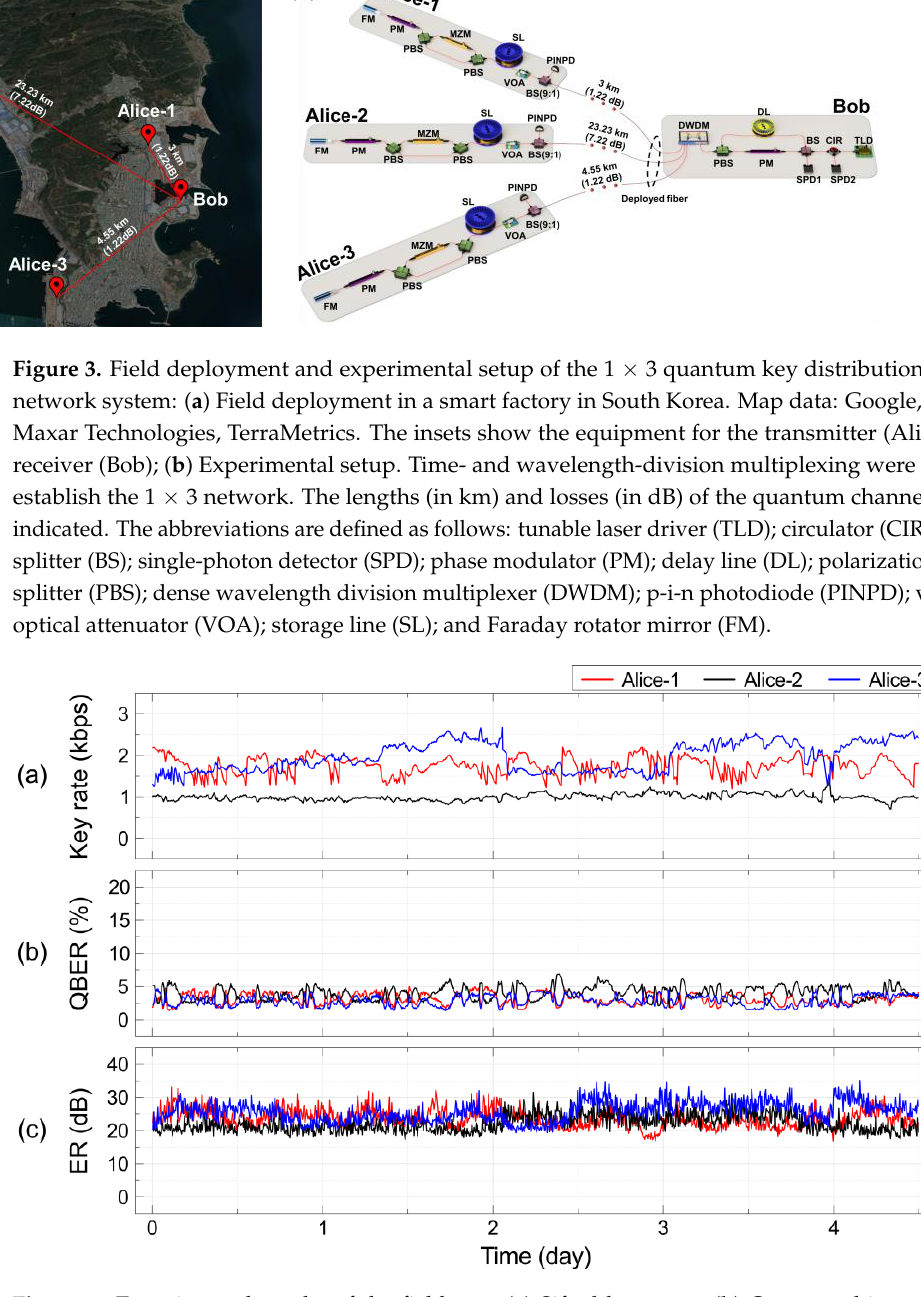
Figure 3. Field deployment and experimental setup of the 1 × 3 quantum key distribution (QKD)